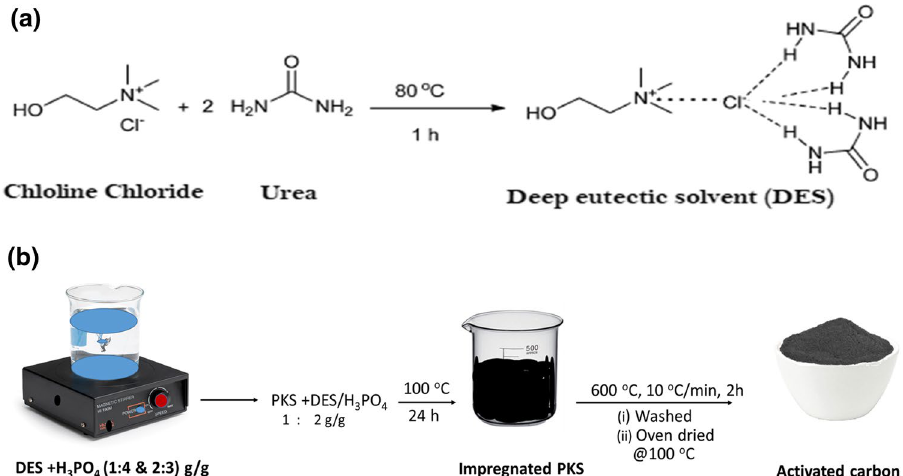
Fig. 1 Synthesis rout of DES/ H 3 PO 4 based